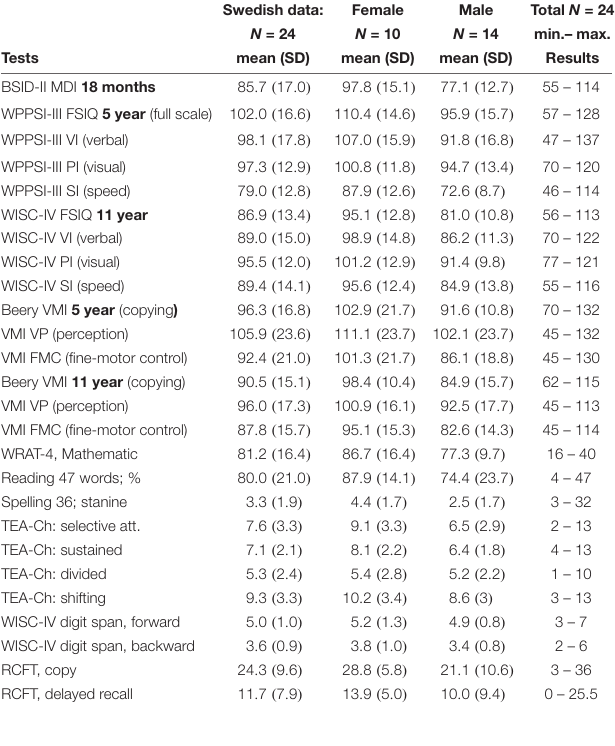
TABLE 3 | Test results for the Swedish cohort.